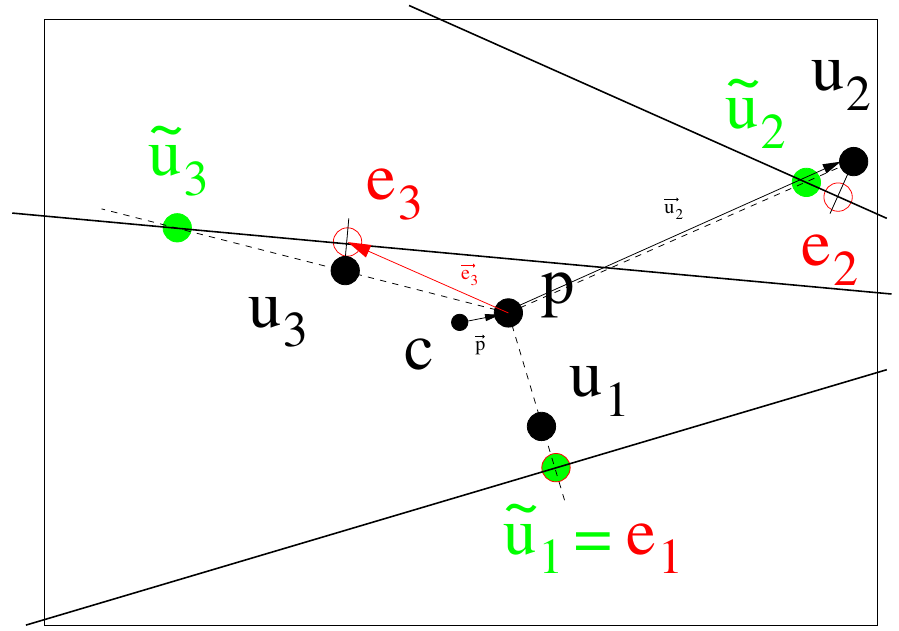
u i Figure 3. Properties for observations and their respective epipolar lines (black solid lines). { } The radial correction function works best when the radial vector is perpendicular to its respective epipolar line, such as (cid:126) u 1 , pointing from p to u 1 , because the geometry is then optimal. Then, the intersection of the radial vector and the epipolar line is, at the same time, the closest point on the line, ˜ u 1 = e 1 . In contrast, the radial vector of point u 3 is almost parallel to its respective epipolar line. Here, the function is bound to overestimate the correction, even if the closest point on the line e 3 is close to u 3 . The most typical case u 2 is in between the previous two. The center of distortion p differs from the center of the image c = ( w /2, h /2 )